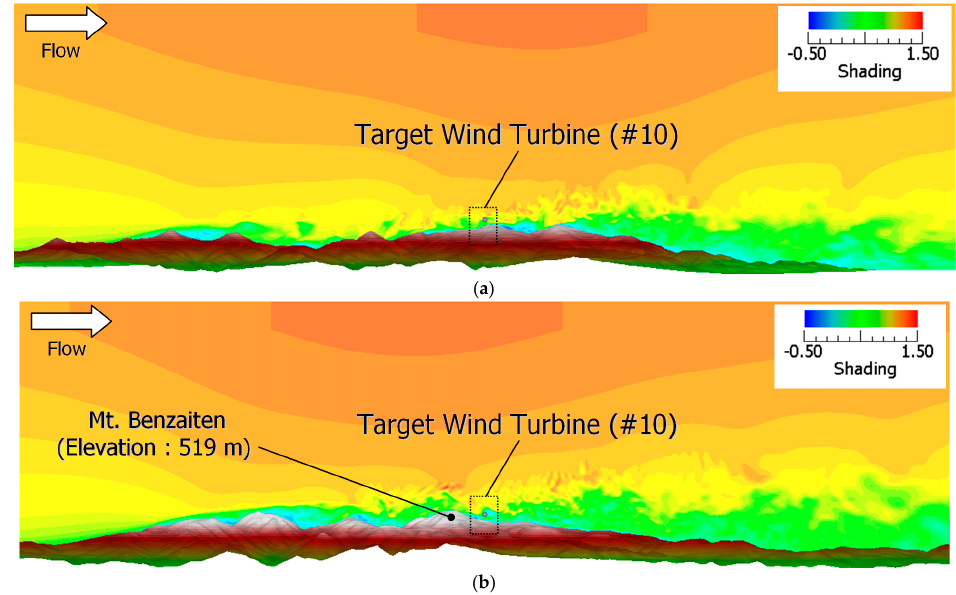
Figure 20. Distribution of the streamwise wind velocity component on a vertical cross-section that includes wind turbine #10 and the instantaneous flow field. ( a ) Northerly wind. ( b ) Easterly wind.